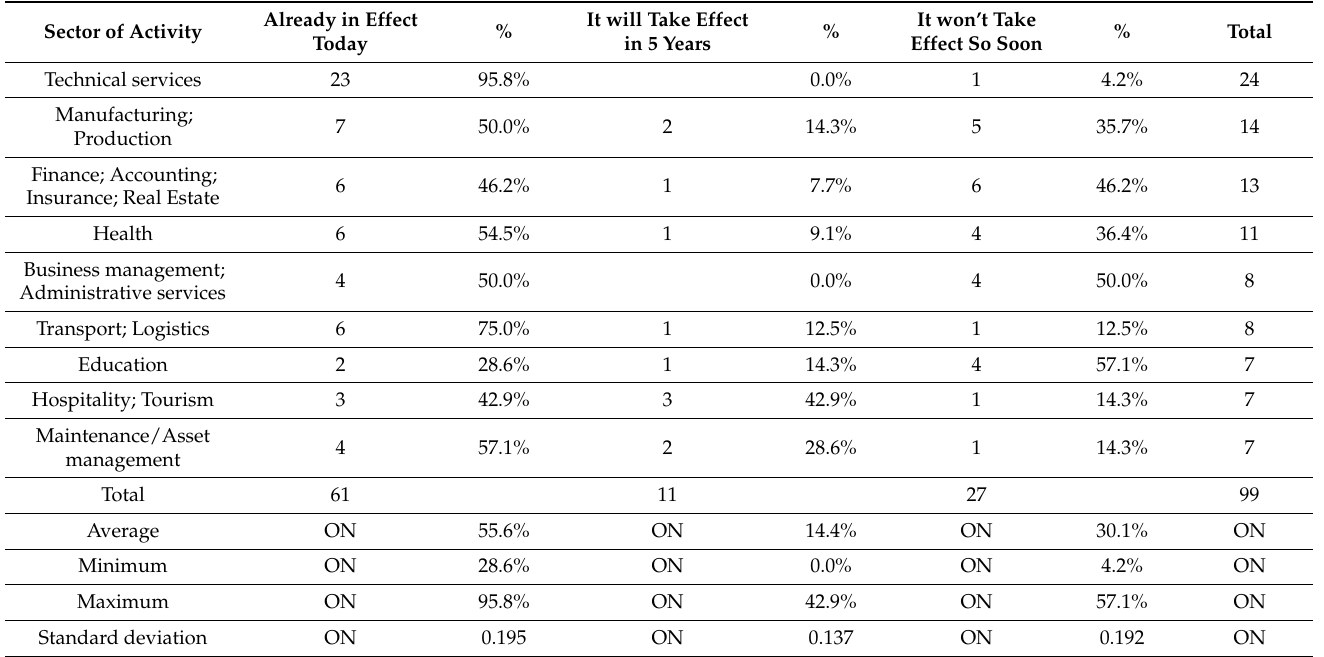
Table 5. Results by activity sector of the question: How soon do you believe that the adoption of intelligent systems will have an effect on your company’s